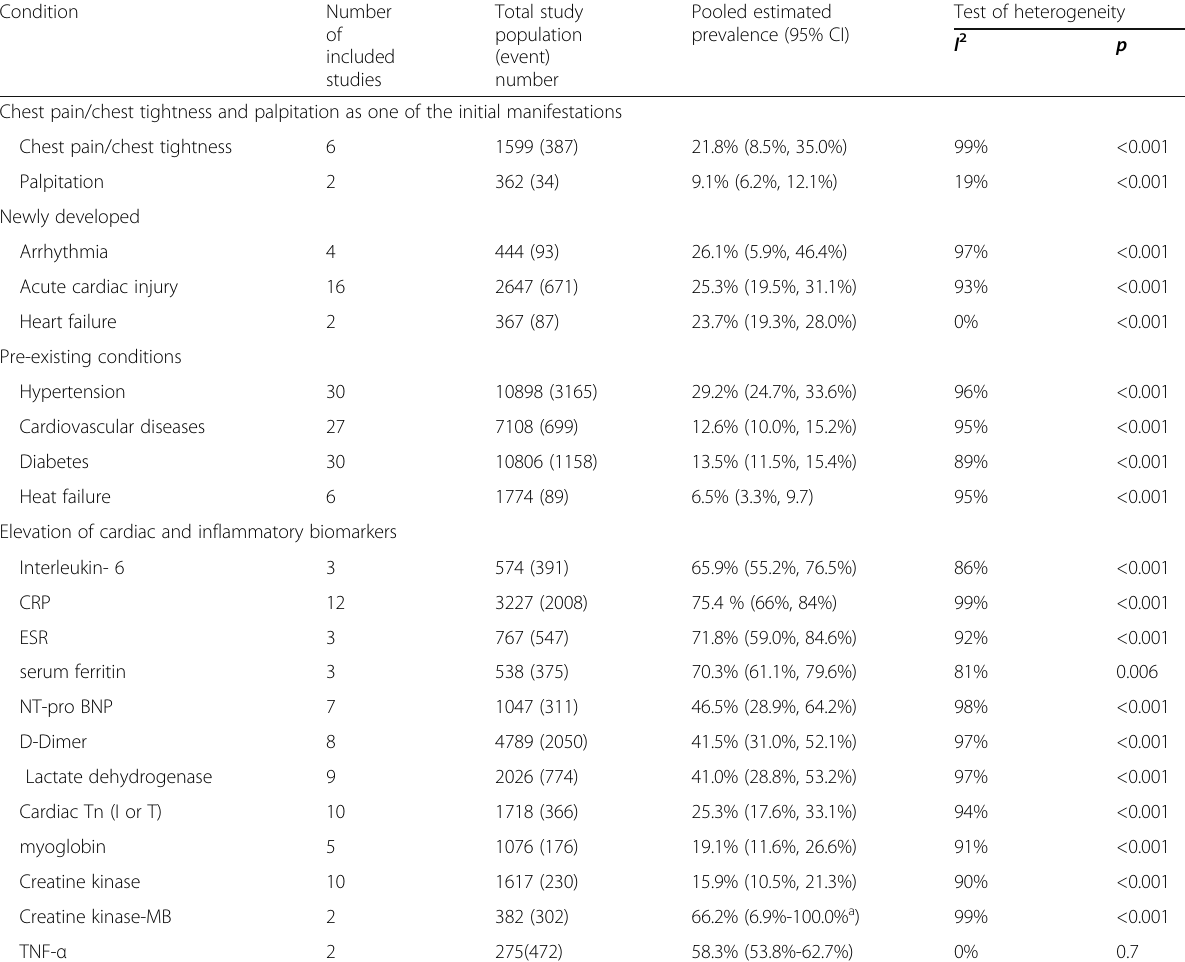
Table 1 The summary of the pooled analysis of frequency of chest pain/chest tightness and palpitation as one of the initial manifestations, newly developed and pre-existing cardiovascular disease, and elevation of cardiac and inflammatory biomarkers in patients with